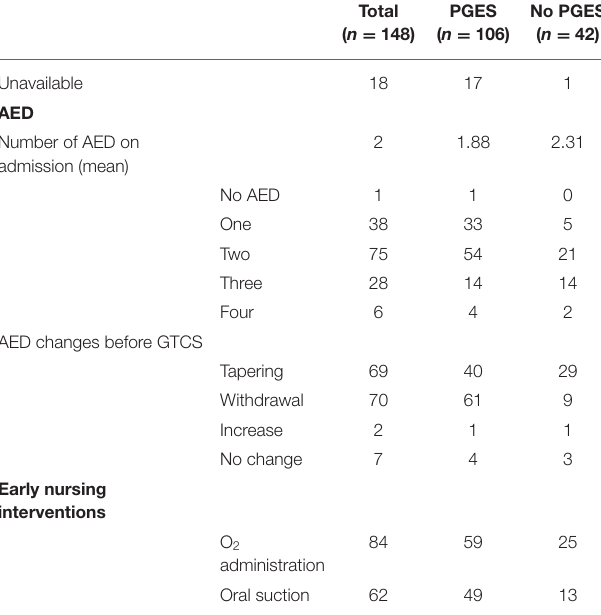
TABLE 1 | Seizure-specific demographic, clinical characteristics and MRI neuroimaging